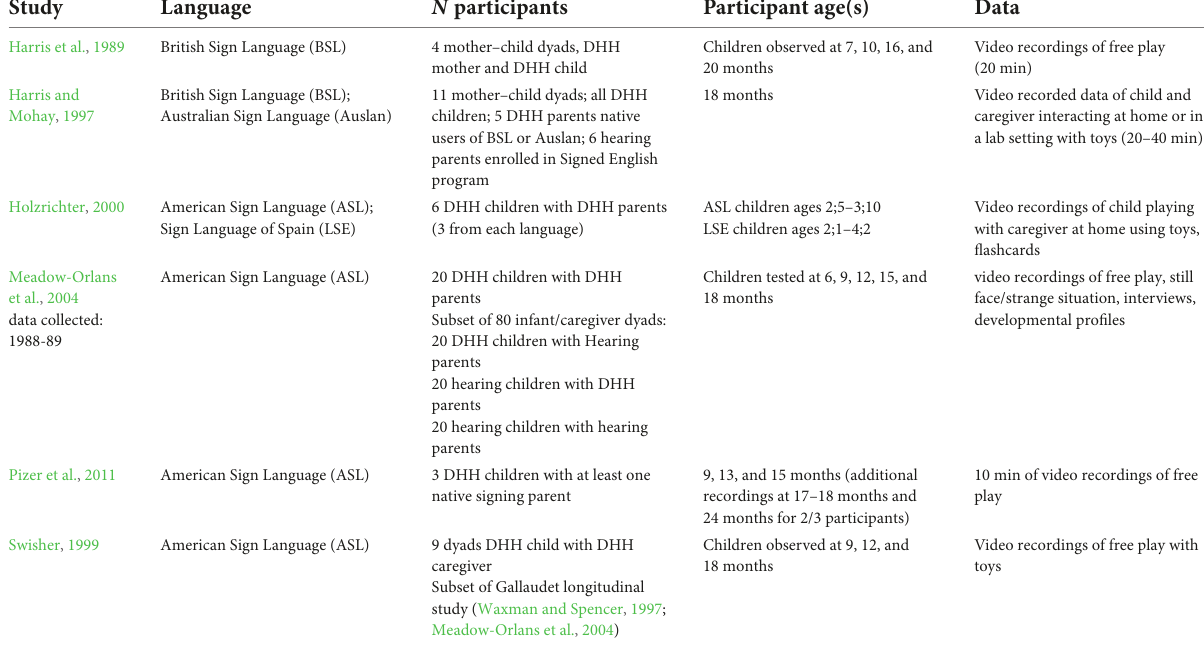
TABLE 6 Studies of sign language development of DHH children of DHH